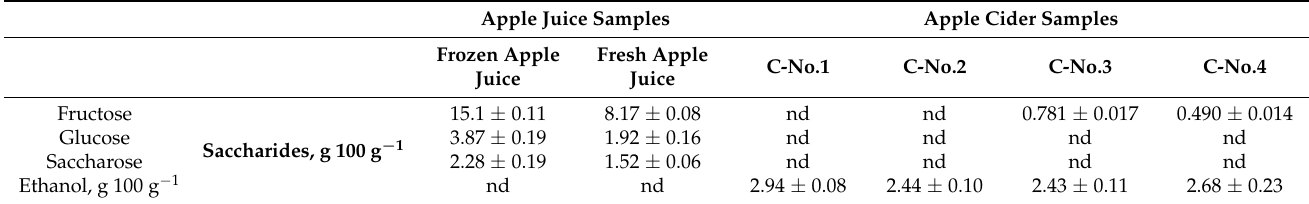
Table 3. Saccharide and ethanol concentrations in non-fermented apple juice and cider samples.